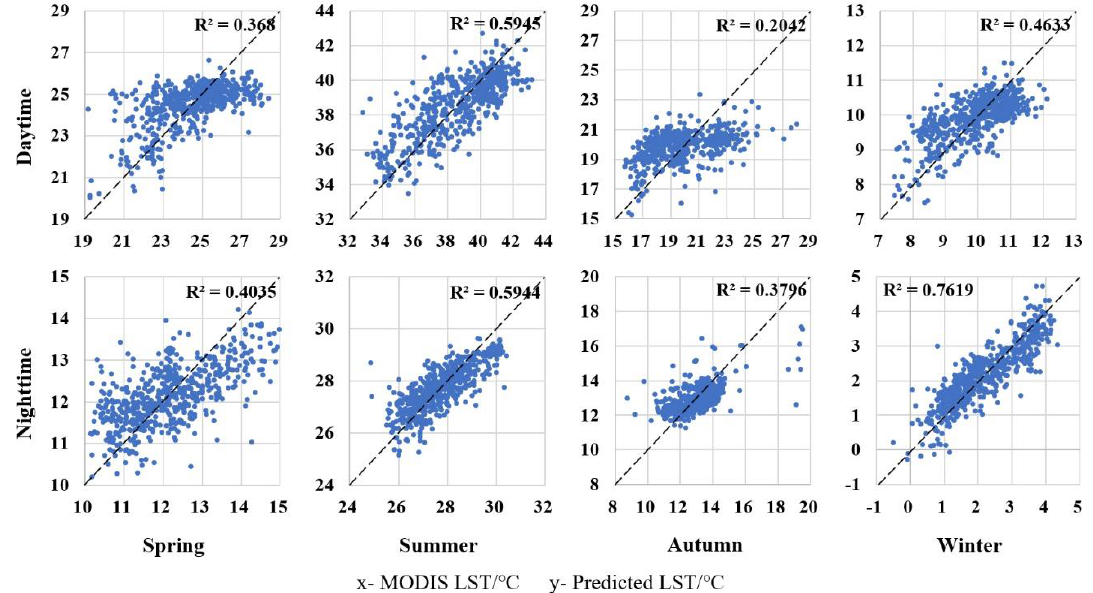
Figure 7. Scatter diagrams of predicted LST data based on the MLR models ( y -axis) versus MODIS LST data ( x -axis). (The black dashed lines represent the 1:1 line; that is, the predicated LST and MODIS LST of the scattered points falling on this line are equal).